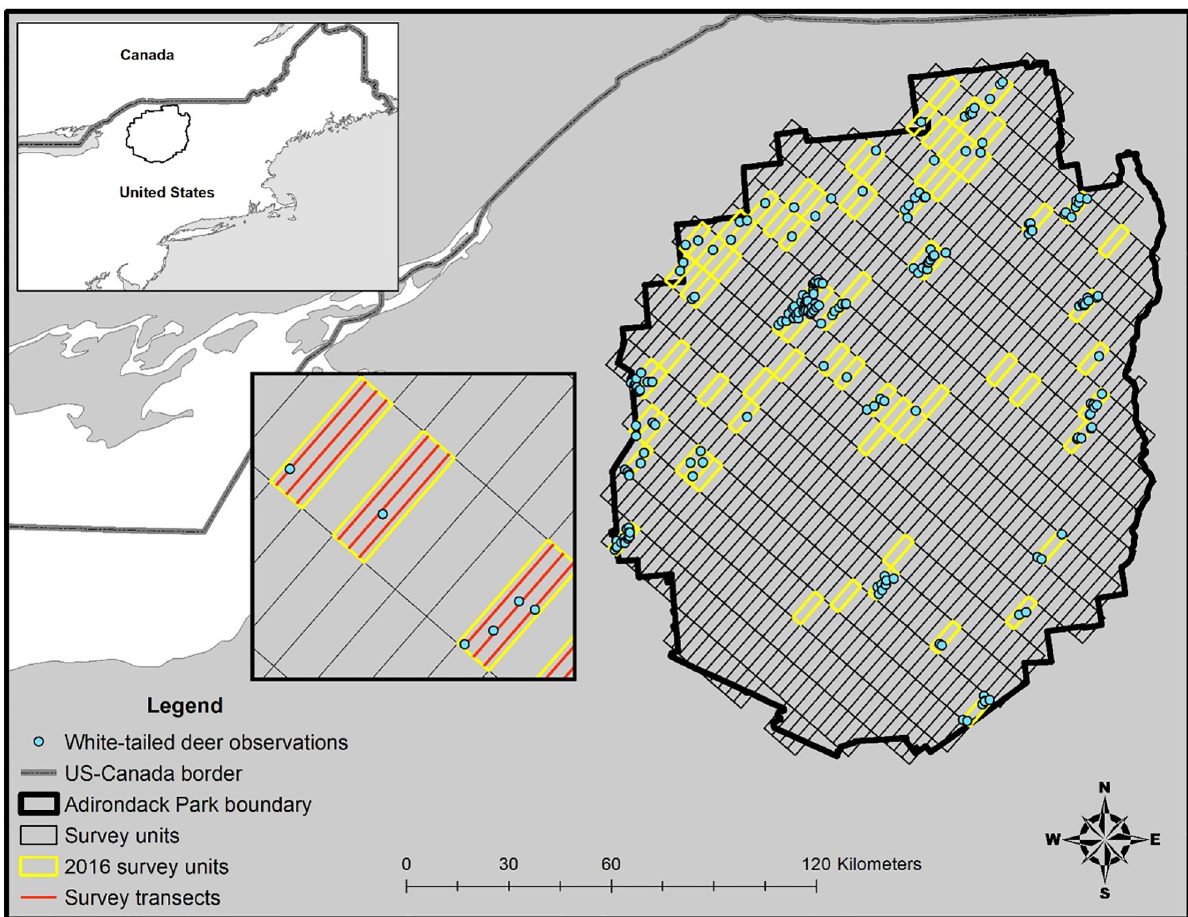
Fig 1. Our study area in the Adirondack Park of northern New York where we conducted aerial surveys of white-tailed deer using distance sampling methods during winter 2016. The rectangular grids represent the 30-km 2 (10 km x 3 km) survey units available for distance sampling of white-tailed deer and moose. The grids outlined in yellow represent survey units that were randomly surveyed during 2016 to estimate parkwide abundance of white-tailed deer.